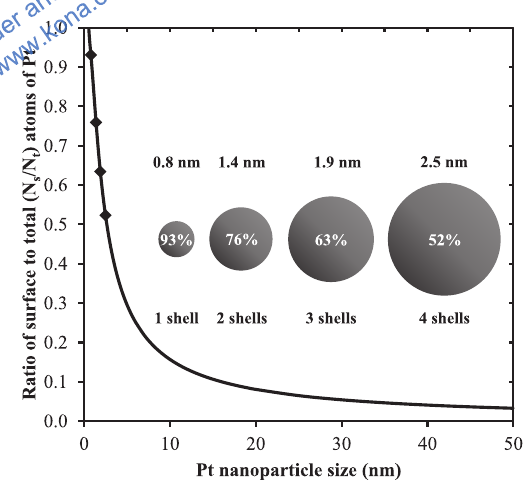
Fig. 4 Ratio of surface to total ( N s / N t ) atoms as a function of the Pt nanoparticle size (inline graphic indicates the size and percentage of Pt nanoparticles for 1 to 4 shells in the fcc cluster).